Question: Generate an informative caption for the figure above.
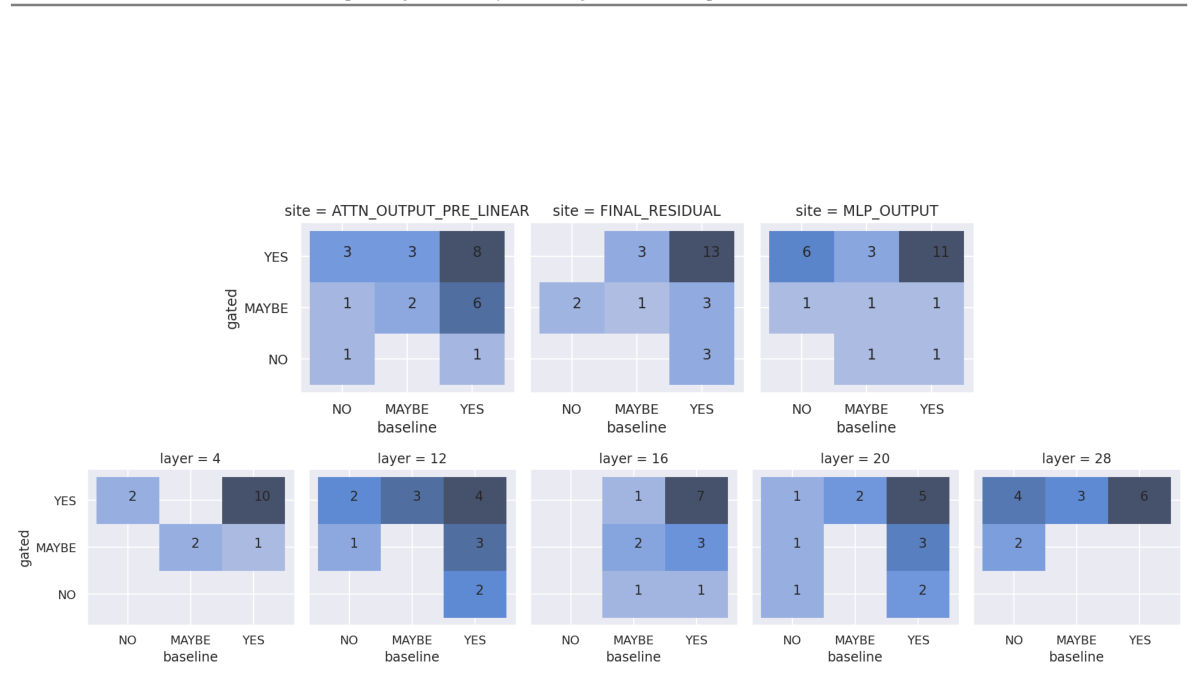
Answer: | Contingency tables for the paired (gated vs baseline) interpretability labels, for Pythia-2.8B